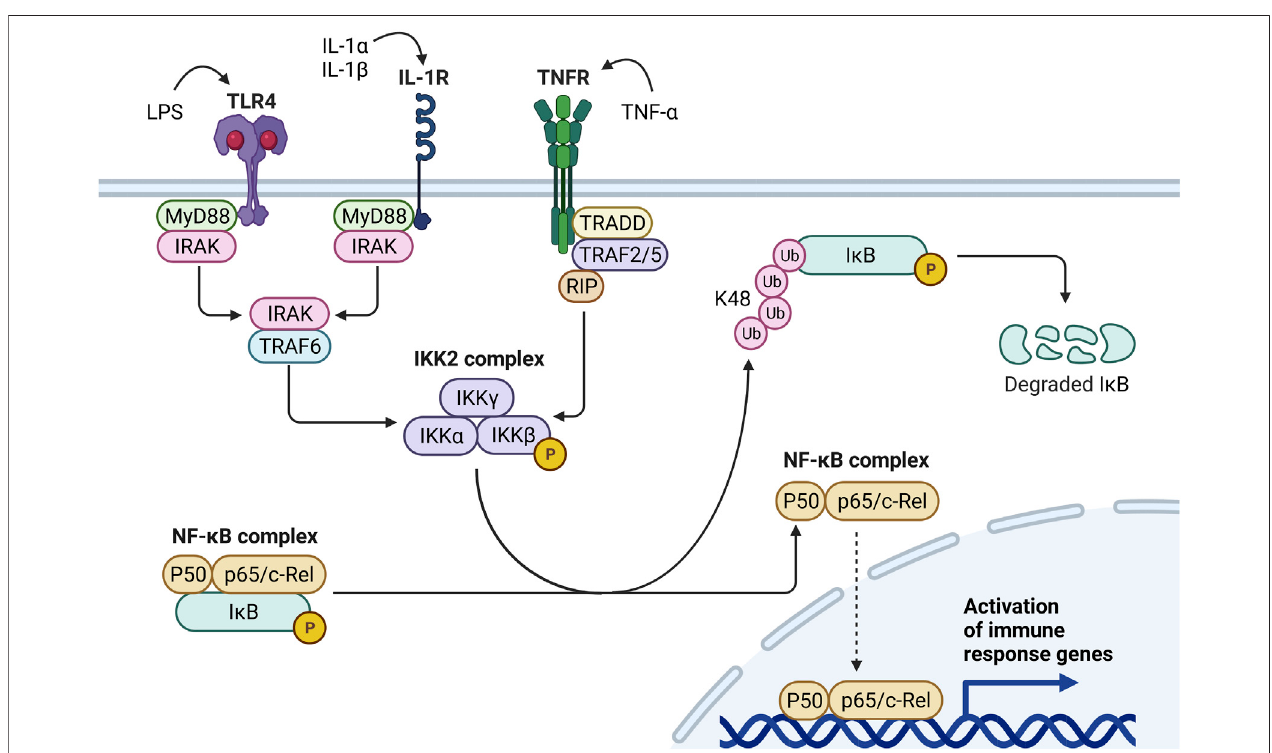
FIGURE 2 | Mechanisms of Signal 1 in fl ammasome priming. In fl ammasome priming can be triggered by diverse stimuli including bacterial molecules (e.g., LPS), alarmins(e.g.,IL-1 α ),orproin fl ammatorycytokines(e.g.,IL-1 β ,TNF- α ).LPSbindstoTLR4,activatestheMyD88-IRAK-TRAF6pathway,andinducesIKK β activity within the IKK2 complex. Likewise, by binding IL-1R, IL-1 α and IL-1 β promote IKK β activity through the MyD88-IRAK-TRAF6 pathway. Conversely, when TNF- α binds TNFR, the TRADD-TRAF2/5-RIP pathway induces IKK β activity. Once activated, IKK β phosphorylates I κ B within the NF- κ B complex, targeting I κ B for K48 polyubiquitination and proteasomal degradation. I κ B degradation liberates the NF- κ B complex (i.e., P50 and p65/c-Rel) and enables its translocation to the nucleus, where it upregulates proin fl ammatory cytokines, chemokines, and other immune response